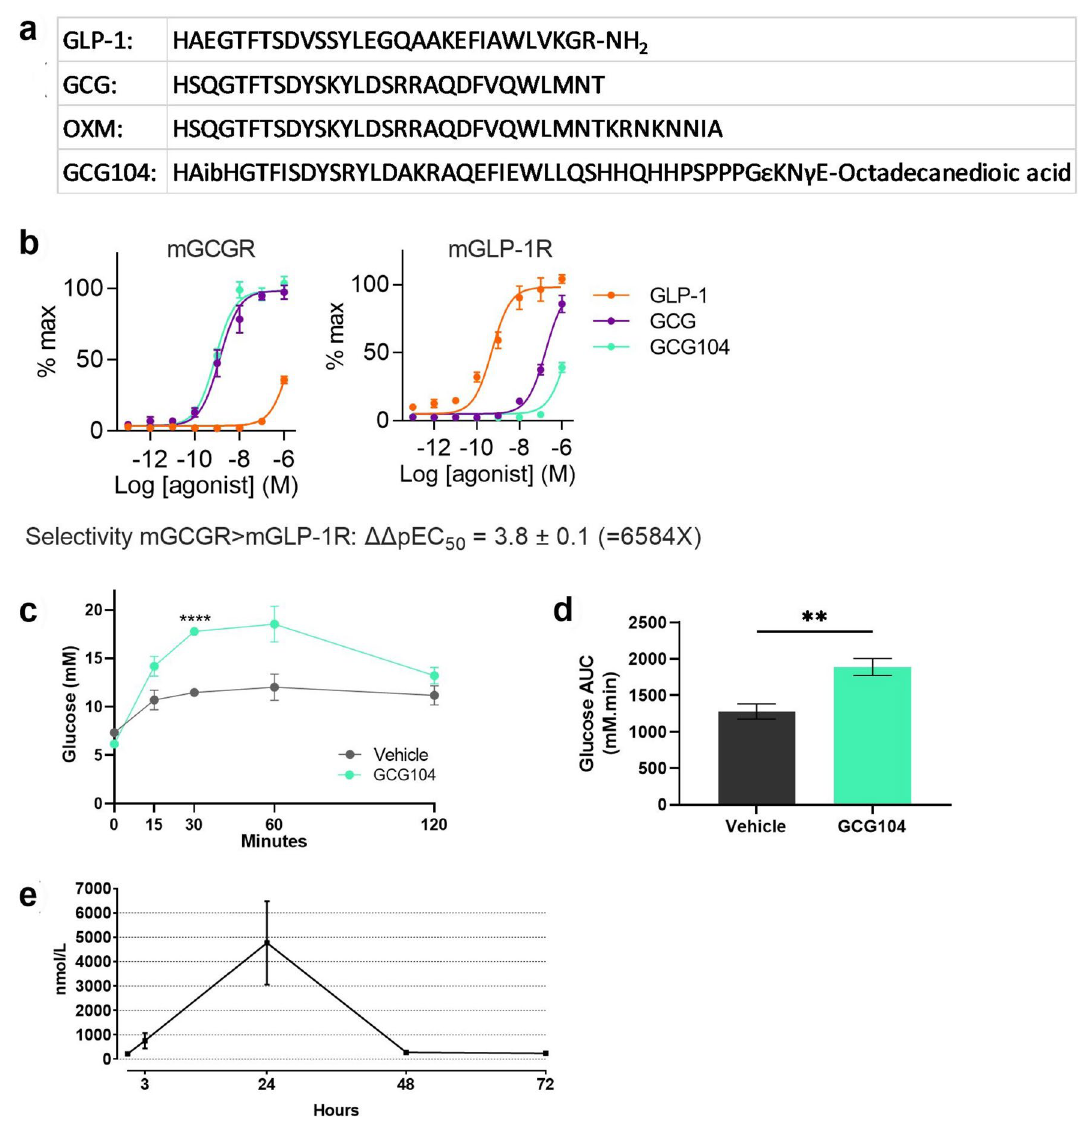
Figure 1. Pharmacological profile of GCG104 in vitro and in vivo. ( a ) Primary structure of native GLP-1, glucagon (GCG), oxyntomodulin (OXM) and GCG104. Sequences are given in standard single amino acid code with Aib denoting alpha-amino isobutyric acid. ( b ) % max cAMP accumulation following GCG104, GLP-1 or glucagon treatment to HEK293 cells transiently expressing mGCGR or mGLP-1R (n = 4 for all tests). ( c ) Glucose response following vehicle or 10 nmol/kg GCG104 injection in 2 h fasted wild-type mice (n = 4 per group; 2-way ANOVA with Sidak post hoc test). ( d ) Corresponding glucose area under the curve for graph c (unpaired t test). ( e ) Pharmacokinetic profile of GCG104 in rats following 0.5 mg subcutaneous injection (n = 5 per group). All data presented as mean ± SEM. p values indicated by ** p < 0.01, **** p <